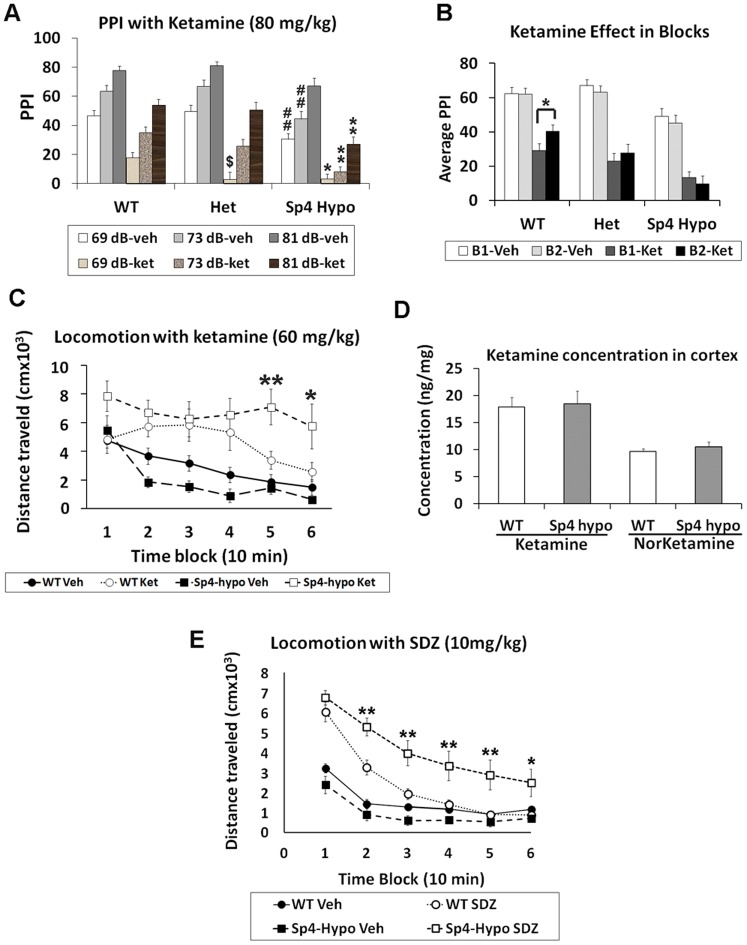
Increased sensitivity and prolonged responses to NMDAR antagonists.(A) There was a significant reduction of PPI in Sp4 hypomorphic mice (n = 21) in comparison with both wildtype (n = 24) and heterozygous mice (n = 19) (## p<0.01). $: significantly lower PPI in heterozygous (p<0.05) than in wildtype mice treated with ketamine with 69 dB prepulses. Asterisks (*): significantly lower PPI in Sp4 hypomorphic (* p<0.05; ** p<0.01) than in wildtype mice treated with ketamine. (B) PPI session was divided into two time blocks. Significant PPI recovery was observed during the second block (B2) in wildtype mice, but not Sp4 hypomorphic mice, treated with ketamine. * p<0.05. (C) In video-track test, no significant difference between wildtype and Sp4 hypomorphic mice treated with saline vehicle. Ketamine significantly increased total distance traveled in both groups. Significantly more locomotion was observed in Sp4 hypomorphic mice than in wildtype mice treated with ketamine in the last 20 minutes of recording (* p<0.05; ** p<0.01). (D) No difference was found in the concentrations of either ketamine or norketamine in the cortex of wildtype (n = 5) and Sp4 hypomorphic (n = 5) mice. (E) In BPM locomotion tests, there was a trend of lower locomotion in Sp4 hypomorphic mice injected with saline vehicle. Administration of SDZ 220–581 increased locomotion in both genotypes, but significant more locomotion was observed in Sp4 hypomorphic mice (n = 9) than in wildtype mice (n = 13), particularly at later blocks (* p<0.05; ** p<0.01).